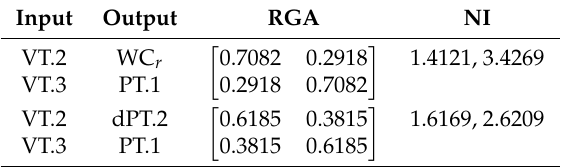
Table 4. Relative gain array (RGA) and Niederlinski index (NI) for the